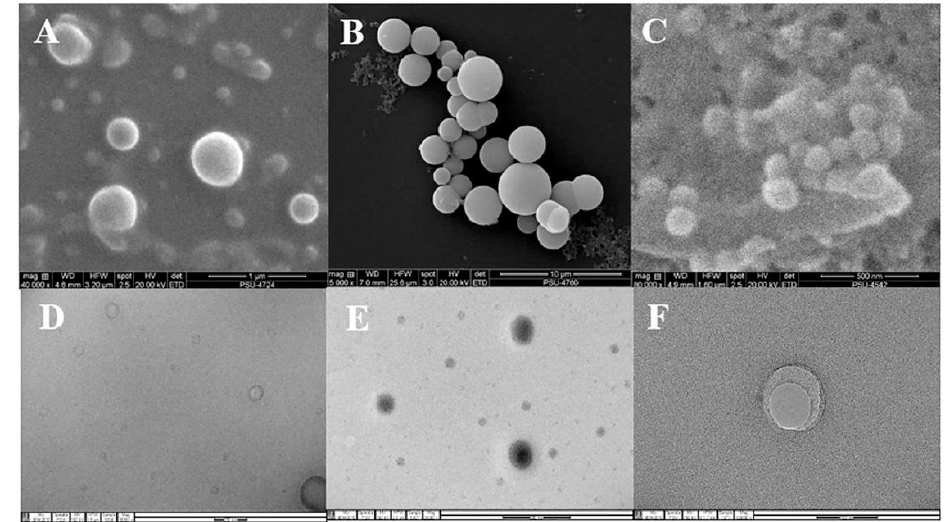
Figure 2. SEM photographs of liposome ( A ), invasome ( B ), and transfersome formulations ( C ), and TEM photographs of liposome ( D ), invasome ( E ), and transfersome formulations ( F ). Reprinted with permission from reference [33]. Copyright 2018,